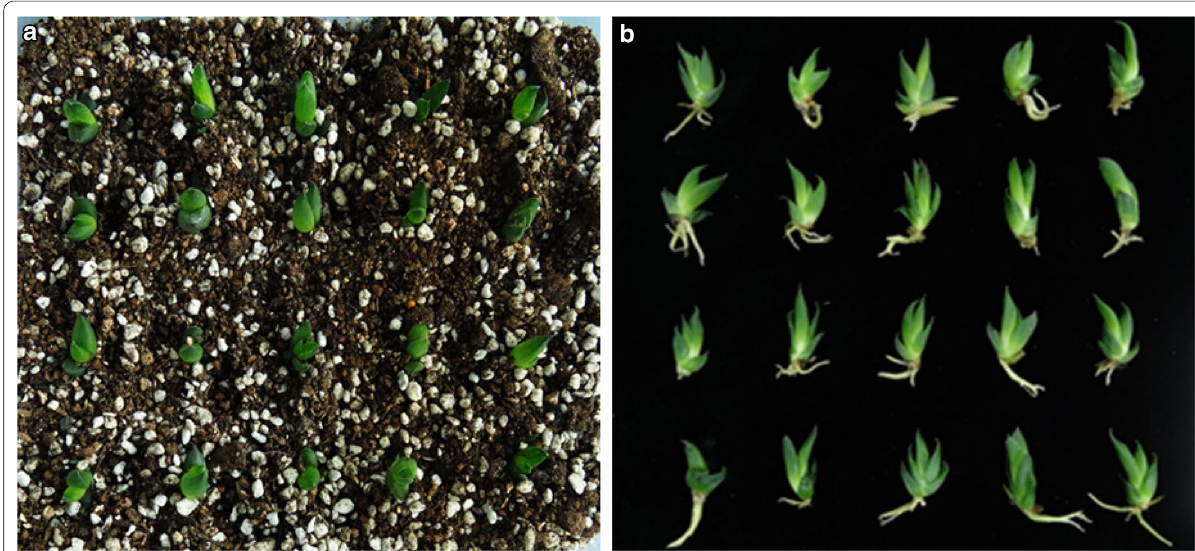
Fig. 4 Haworthia ‘Sansenjyu’ plantlets ( a ) grown in a vermiculite, perlite and soil mixture under greenhouse conditions after 4 weeks, and ( b ) the root